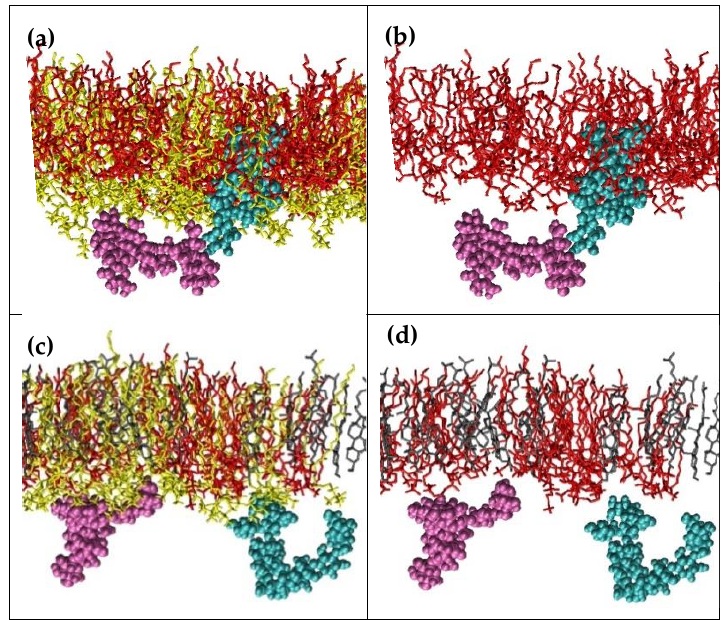
Figure 8. Side views of SM/POPC ( a , b ) and SM/POPC/CHOL 30 mol% ( c , d ) monolayers interacting with GOTCAB molecules, the last frame of production run trajectories. Panels ( a , c ): POPC shown; ( b , d ): POPC not displayed. Aliphatic hydrogens are removed for clarity. Color code: SM: red, CHOL: gray, POPC: yellow, GOTCAB: for more clarity, the two identical molecules are presented in cyan and mauve.